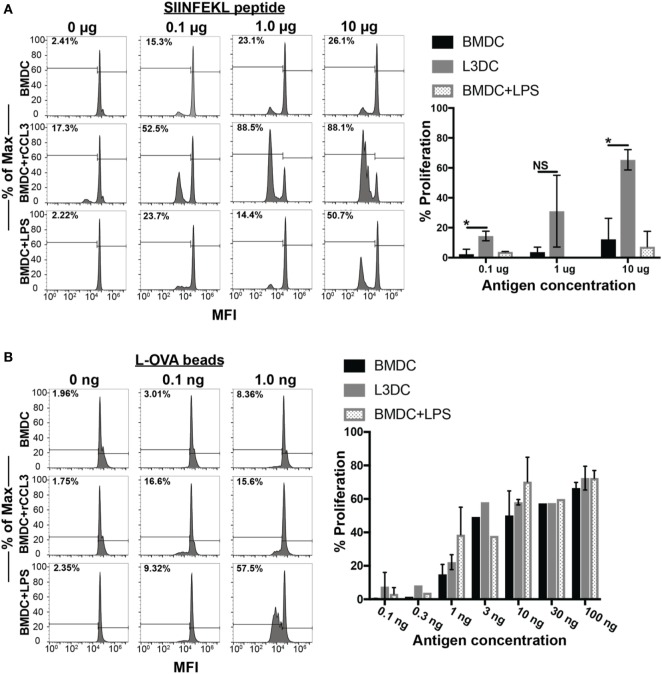
Pretreatment with recombinant CCL3 (rCCL3) enhances the capacity of bone marrow-derived DCs (BMDCs) to drive OT-I proliferation in vitro. (A) Day 7 BMDCs were cultured for 24 h in the presence or absence of CCL3 (100 ng/ml) or LPS (100 ng/ml), then washed and pulsed with the indicated concentration of SIINFEK peptide, and plated in the presence of CFSE-labeled (1μM) naive OT-I T cells at 1:5 BMDC-to-T cells ratio for 72 h. A total of three independent experiments were performed. (B) Day 7 BMDCs were cultured for 24 h with media, 100 ng/ml rCCL3 or LPS (100 ng/ml), then washed and incubated with OVA-latex beads at varying concentrations with CFSE-labeled (1 μM) naïve OT-I T cells at 1:5 BMDC-to-T cells ratio for 72 h. Quantification of FACS data in (A,B) are summarized in the bar graphs. Quantification of results in (A,B). Each bar was calculated after subtracting the background CFSE dilution in the absence of added antigen. Each graph is representative of three to four experimental replicates. Not significant (ns), p > 0.05; *p = 0.01–0.05; **p = 0.001–0.01; ***p = 0.0001–0.001; ****p < 0.0001.